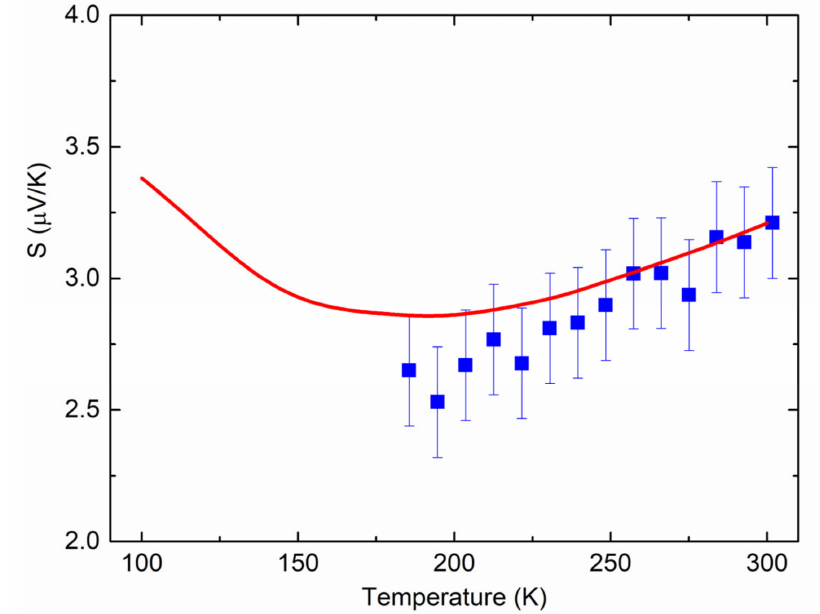
Figure 4. Measured temperature dependence of S Cu − S Al (squares). Line is the difference of S Cu and S Al adapted from [25] and [24], respectively, with permissions from IOP publishing, 1958 (© IOP Publishing. Reproduced with permission. All rights reserved) and Taylor & Francis,